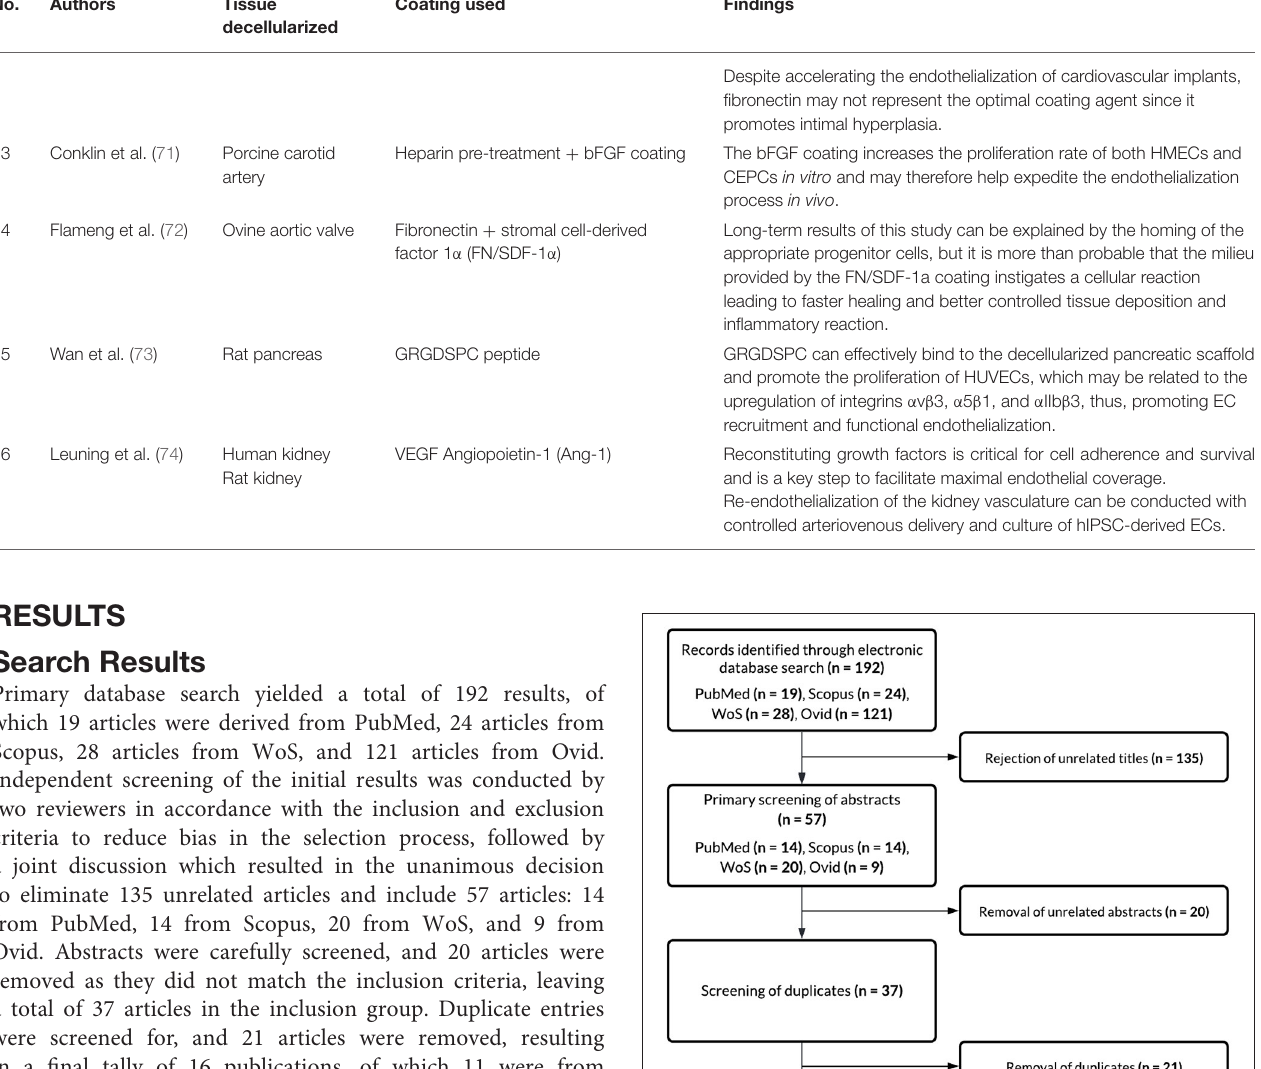
Table 1 . Effects of the coating agents on the re-endothelialization of decellularized vascular grafts are further